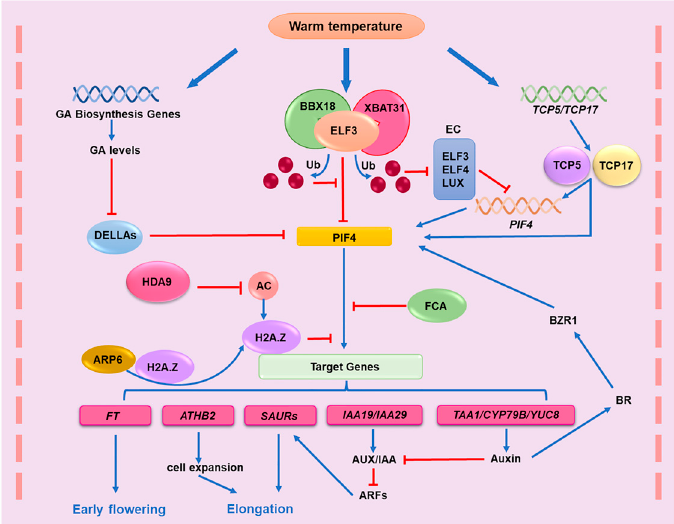
Figure 3. Schematic representation of PIF4-mediated thermomorphogenesis through the regulation of the auxin signaling pathway in plants. Warm temperatures promote PIF4 transcription and protein stability through multiple regulatory mechanisms. PIF4 further positively regulates the auxin response, which promotes thermomorphogenesis in response to moderately elevated ambient